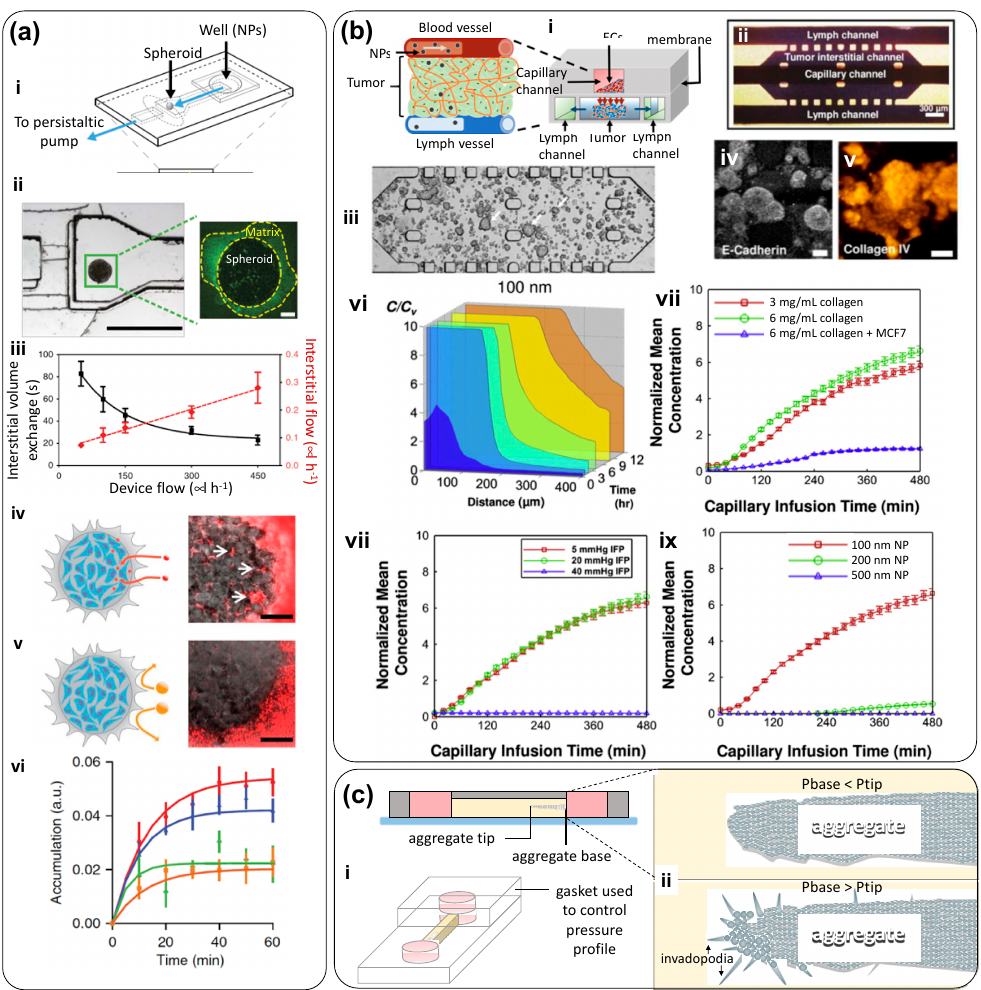
Figure 4. Tumor-on-chip in which a spheroid is embedded in a hydrogel. ( a ) Microfluidic system proposed by Albanese et al. [27]: (i) scheme of the optically accessible TOC, (ii) actual image of the spheroid within the microfluidic chamber (scale bar: 1000 μ m). The tumor spheroid is lightly embedded in collagen. Scale bar: 100 μ m. (iii) Interstitial volume exchange (residence time within a spheroid) as a function of the inlet flow rate (black squares); the corresponding interstitial flow rate is shown (red diamonds). (iv) Scheme and image of 40 nm PEG nanoparticles penetrating the spheroid and accumulating in the interstitial spaces (scale bar: 100 μ m). (v) Larger nanoparticles (d = 110 nm) cannot penetrate the spheroid. Scale bar: 100 μ m. (vi) Nanoparticle of different sizes [40 nm (red); 70 nm (blue); 110 (green), and 150 (blue)] exhibit different accumulation rates within spheroids. Nanoparticles were injected into the chamber at 50 mL/h; ( b ) The tumor on chip designed by Kwak et al. [28] aimed to recapitulate (i) the dynamics induced by the pressure gradient between the capillary and the lymphatic nets. (ii) Scheme (scale bar: 300 μ m) and (iii) actual microdevice: cancer spheroids (indicated by arrows) develop within collagen in the central compartment by day 3. These spheroids, like actual tumors, express (iv) E-cadherin and (v) collagen IV. Scale bar: 50 μ m. This system enables studies of accumulation of nanoparticles within tumors. (vi) Concentration of 100 nm particles at different distances of the capillary boundary (vii) Accumulation of nanoparticles as a function of matrix stiffness, (viii) interstitial pressure, and (ix) particles size. Taken from reference [28]; ( c ) TOC devised by Piotrowsky-Daspit [30] to study the effect of intra-tumor interstitial pressure on tumor invasiveness. (i) Schematic representation of the device; (ii) Micrographs showing an E-cadherin-GFP aggregate under a condition where the pressure gradient favors invasiveness (higher pressure at the tumor core). Modified from Piotrowsky-Daspit